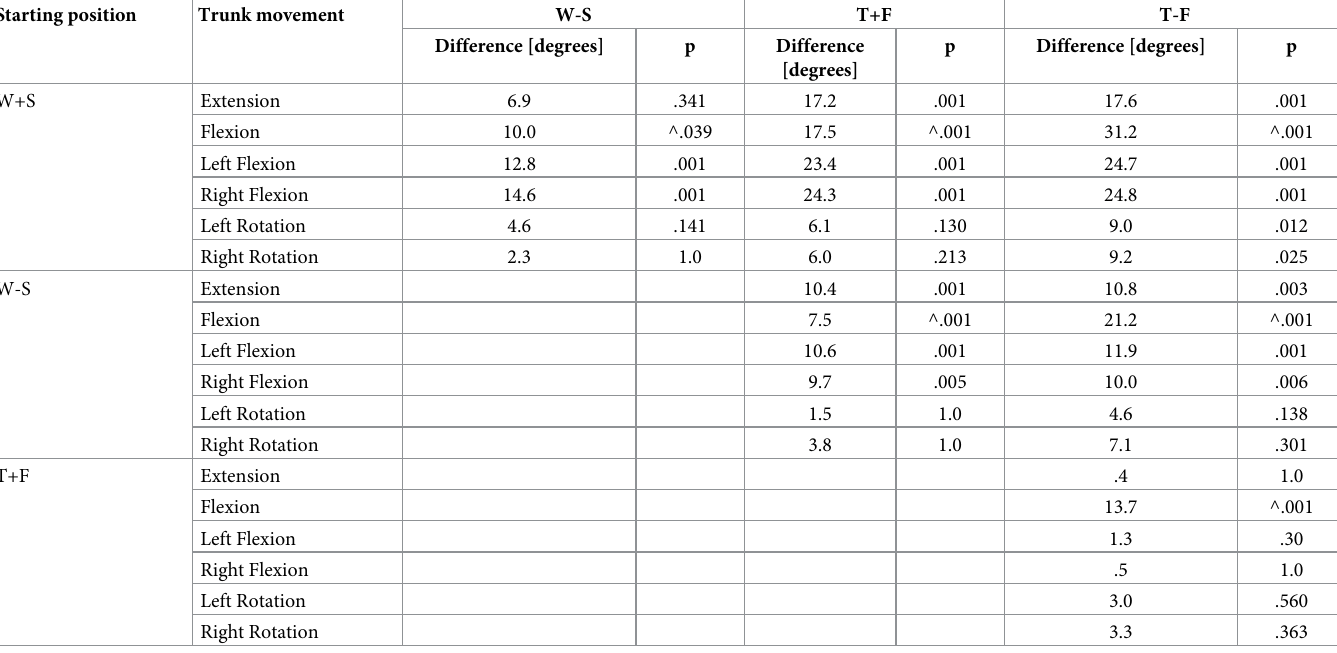
Table 2. Differences in the results of active trunk movement measurements in four different sitting positions in wheelchair athletes. Starting position Trunk movement W-S